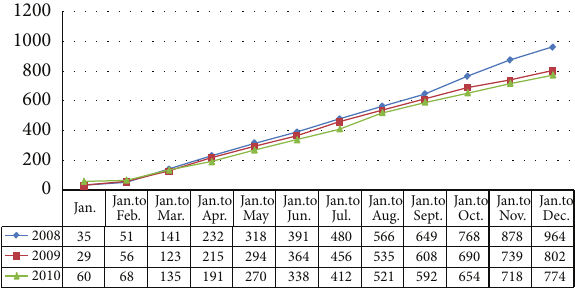
Figure 2: Death tolls from safety accidents in the construction industry